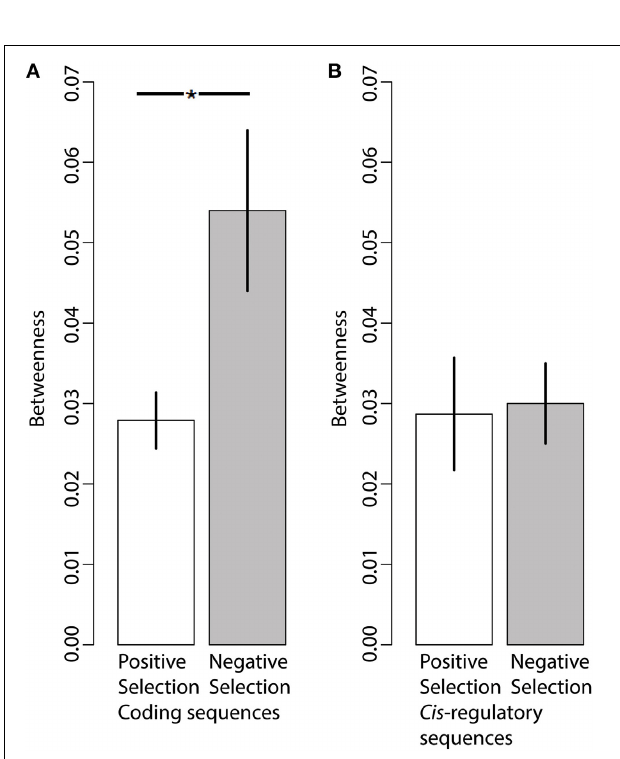
FIGURE 3 | The honey bee brain TRN highlighting genes with adaptively evolving (A) cis -regulatory and (B) coding sequences. Adaptively evolving transcription factors are highlighted in red, while adaptively evolving targets are highlighted in green.